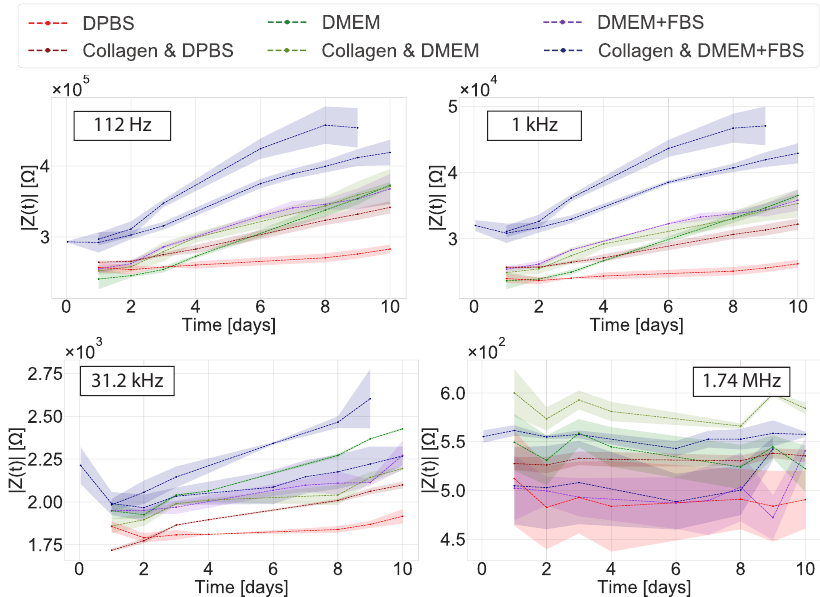
Figure 7. Impedance magnitude plots showing measurements taken daily at 112 Hz, 1 kHz, 31.2 kHz and 1.74 MHz while the electrodes were incubated in standard culture conditions (37 ◦ C, 5% CO 2 ) with and without collagen gels in Dubelcco’s phosphate-buffered saline (DPBS), DMEM, DMEM + FBS. The shaded areas show minimum and maximum of the two replicates.